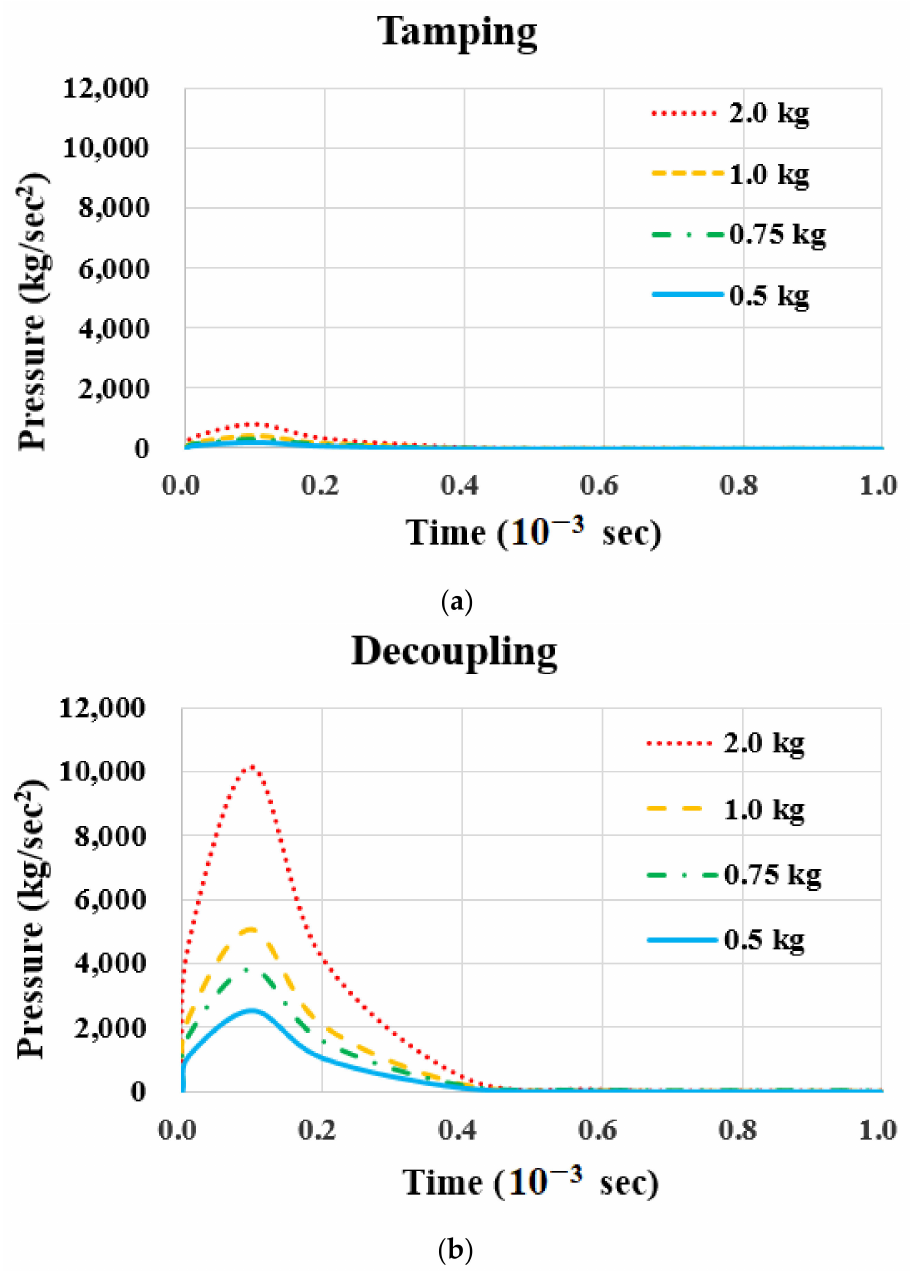
Figure 3. ( a ) Tamping and ( b ) decoupling time history